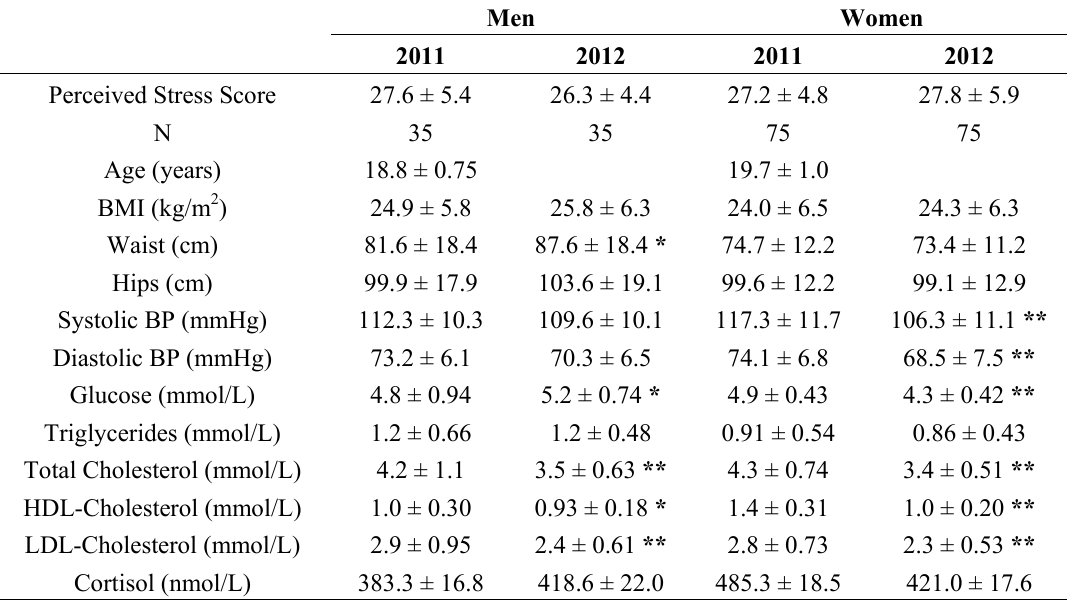
Table 2. General Demographic and Clinical Characteristics of Subjects According to